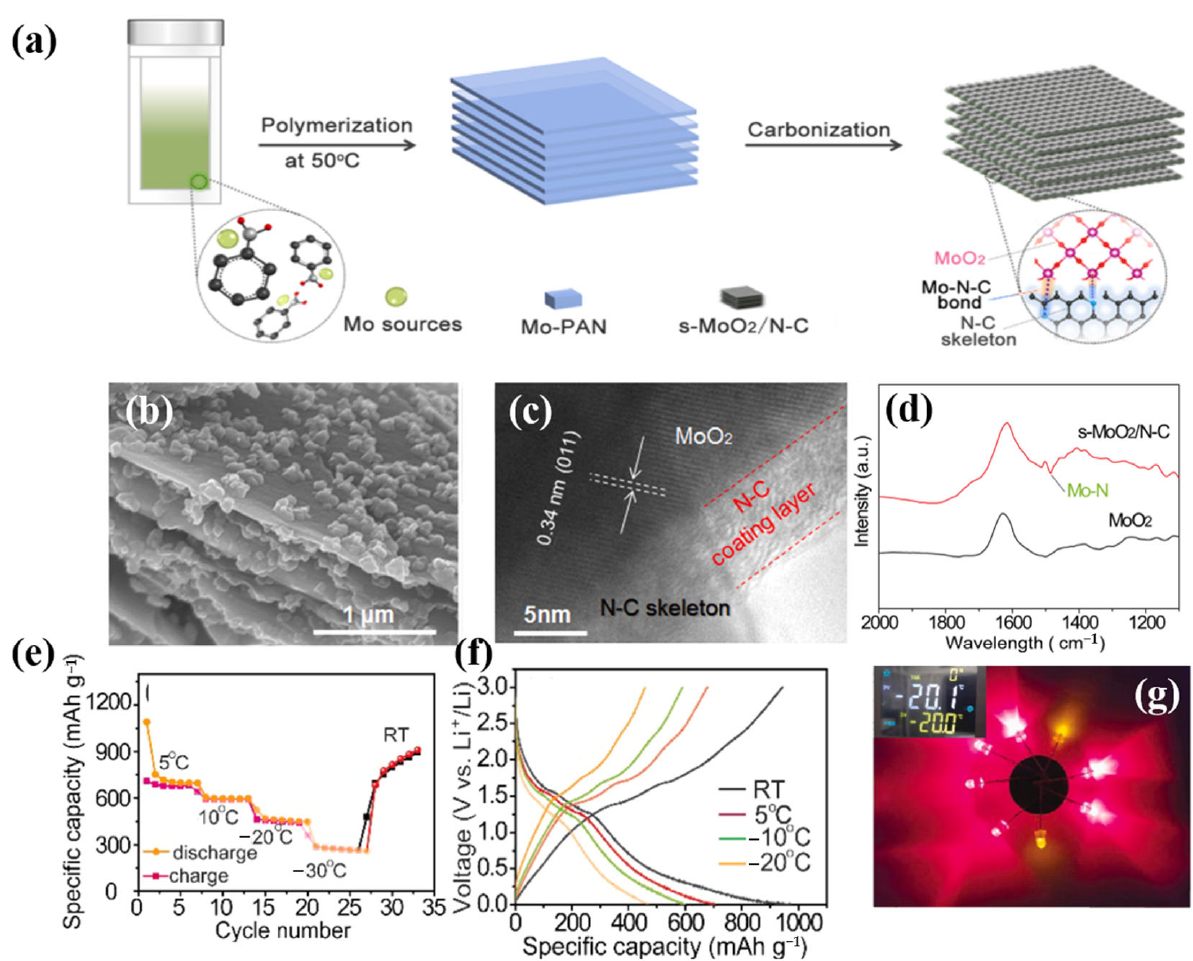
Figure 8. ( a ): Schematic illustration of the synthesis of s ‐ MoO 2 /N ‐ C with strong Mo ‐ N ‐ C chemical bonding interactions through a self ‐ template method. ( b ): SEM images and their corresponding EDS elemental mappings of the prepared s ‐ MoO 2 /N ‐ C composite. ( c ): HRTEM images of s ‐ MoO 2 /N ‐ C. ( d ): FT ‐ IR spectra of s ‐ MoO 2 /N ‐ C and commercial MoO 2 , respectively. ( e ): Capacity retention of s ‐ MoO 2 /N ‐ C at the temperature range of 5°C to − 30°C. ( f ): Galvanostatic discharge/charge profiles ( g ): The photograph shows that the battery using the s ‐ MoO 2 /N ‐ C electrode can light up eight LED bulbs. ( a – g ) Reproduced with permission from [103].